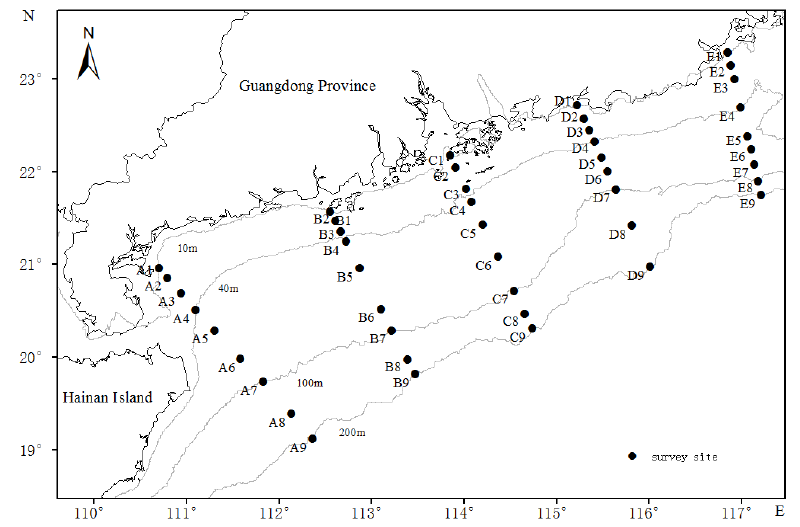
Figure 1. Sampling sites across the northern continental shelf, South China Sea. Zhanjiang (A1 – A9), Yangjiang (B1 – B9), Pearl River Estuary (C1 – C9), Shanwei (D1 – D9), and Shantou (E1 – E9)